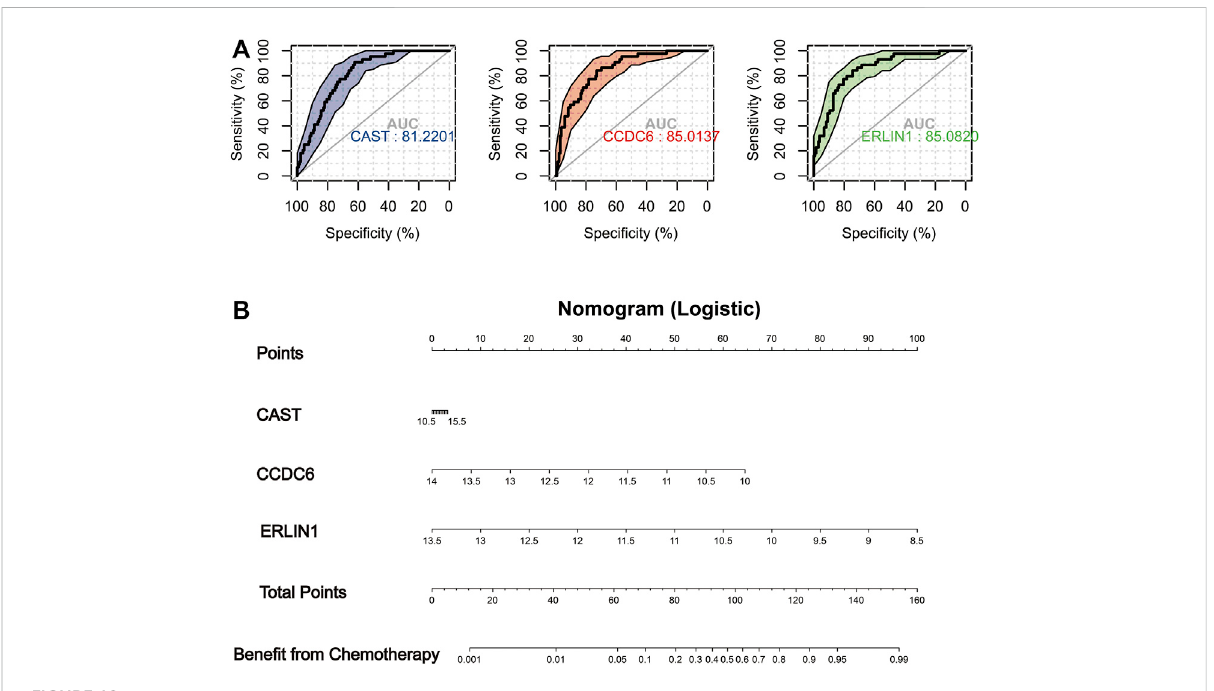
FIGURE 10 (A) In TCGA-PAAD cohort, ROC analysis evaluating diagnostic accuracy of CAST, CCDC6 and ERLIN1 in low mitophagy subtype (cluster B). (B) Construction of a nomogram based on the gene expression of CAST, CCDC6 and ERLIN1 to identify PAAD patients can more bene fi t from chemotherapy (cluster